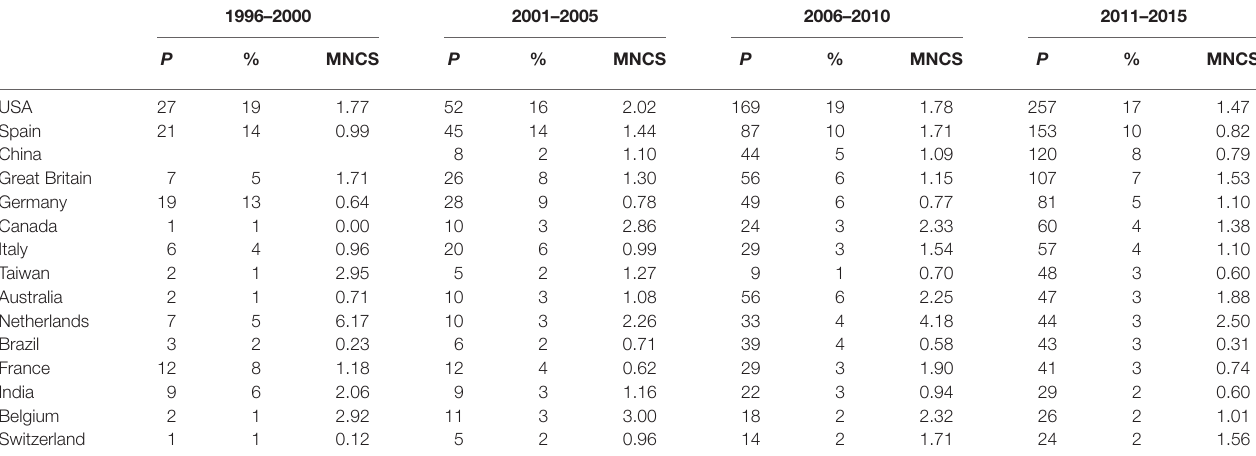
TaBle 3 | Output numbers across countries in Wos on Journal impact Factors,